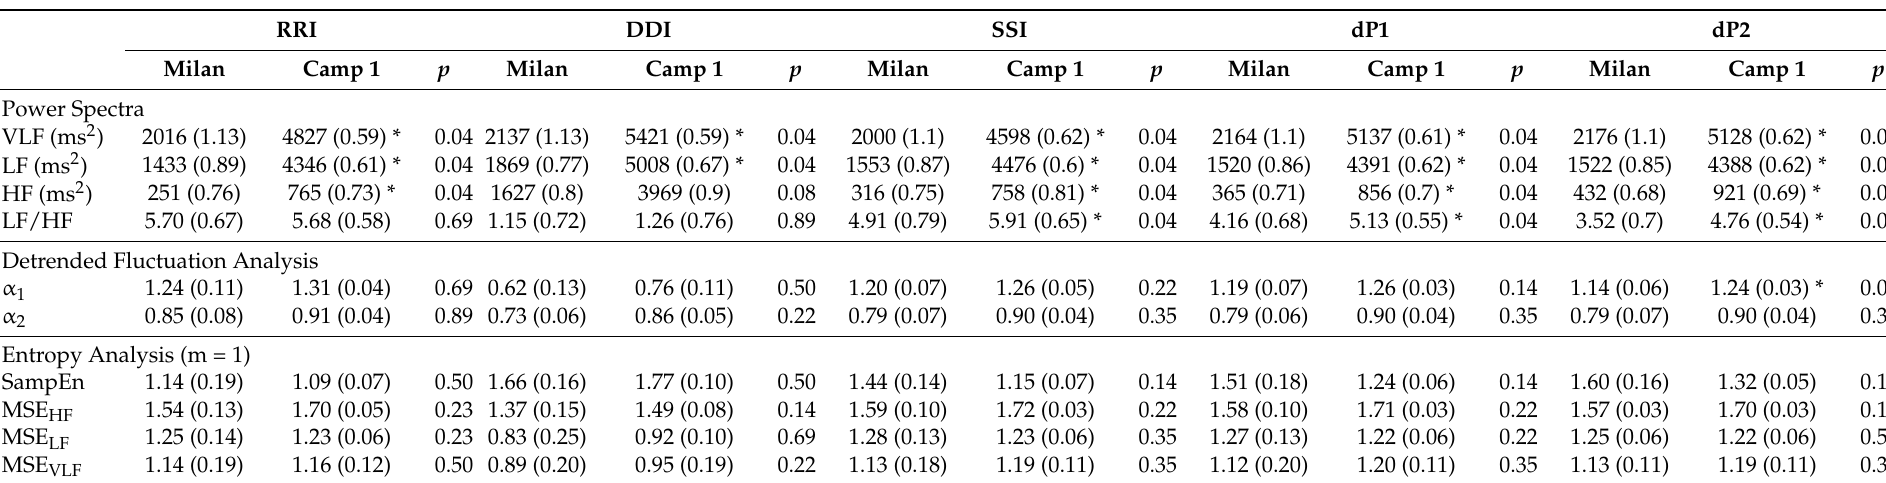
Table 2. HRV indexes in n = 5 climbers sleeping in Milan (sea level) and Everest Camp 1 (6000 m a.s.l.) by type of